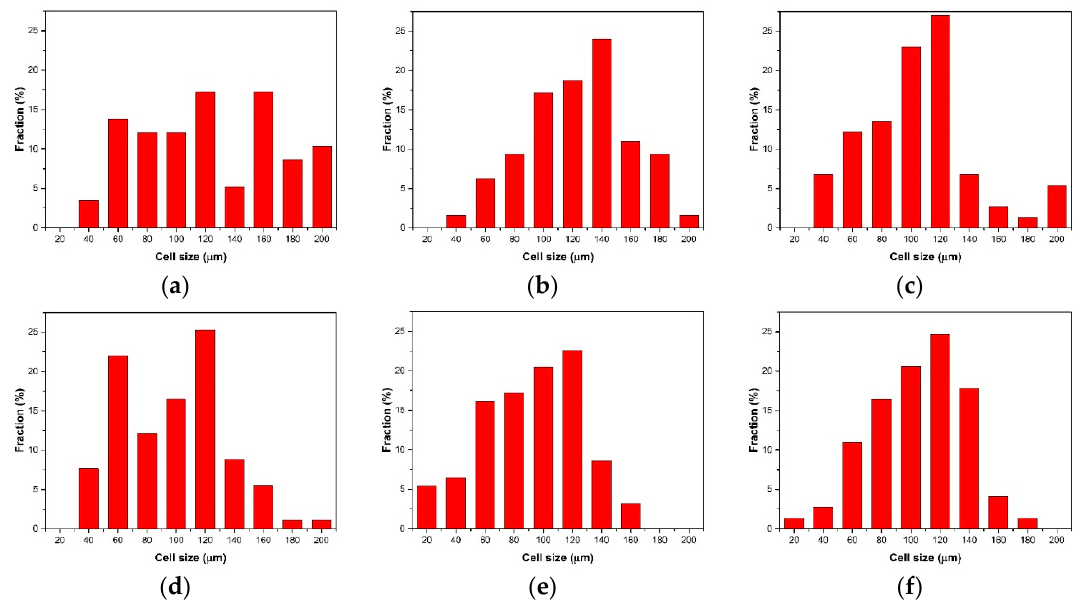
Figure 18. The cell size distribution of the core layer of parallel sections with different contents of nano ‐ CaCO 3 : ( a ) 0 wt %; ( b ) 2 wt %; ( c ) 4 wt %; ( d ) 6 wt %; ( e ) 8 wt %; ( f ) 10 wt %.